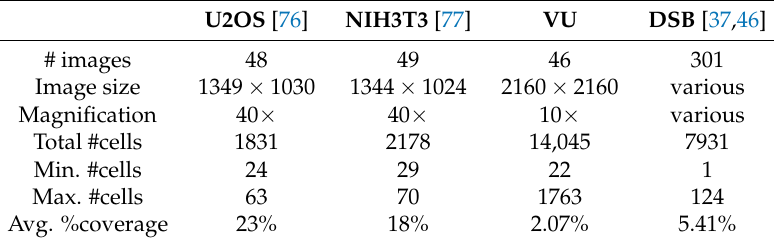
Table 4. Main characteristics of fluorescence microscopy